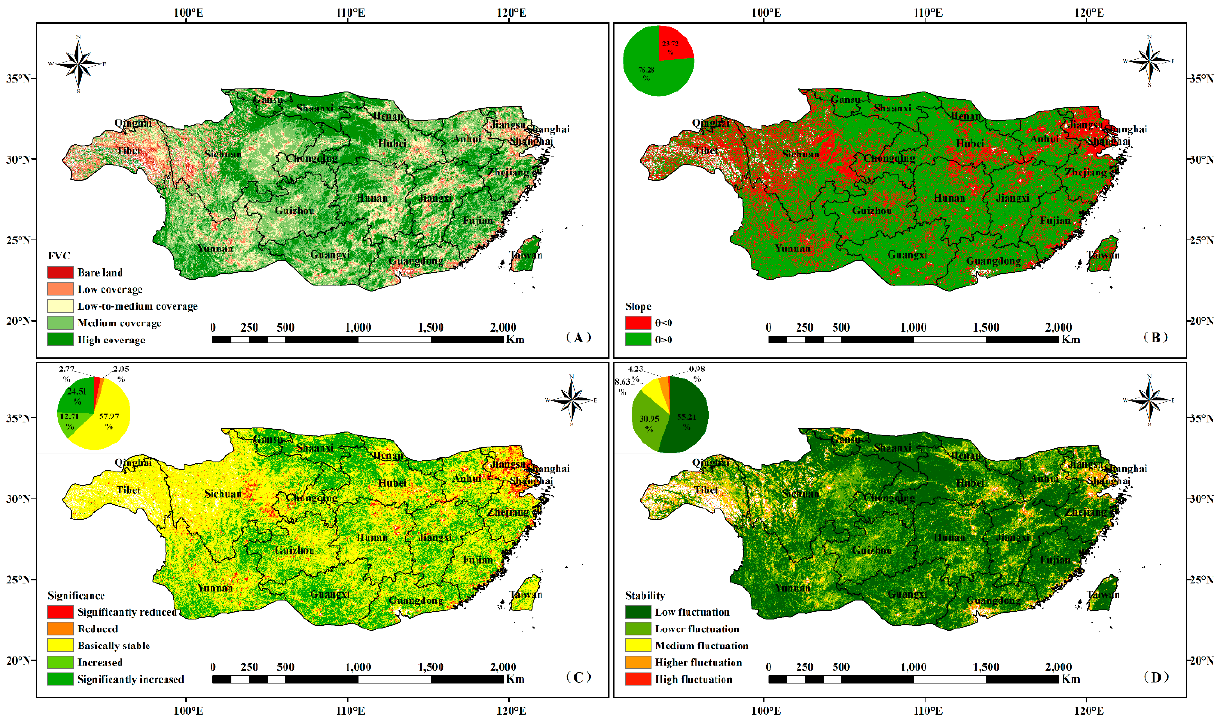
Figure 5. Spatial distribution of ( A ) the mean value, ( B ) trend slope, ( C ) significant changes, and ( D ) stability of the subtropical FVC from 2001 to 2018.